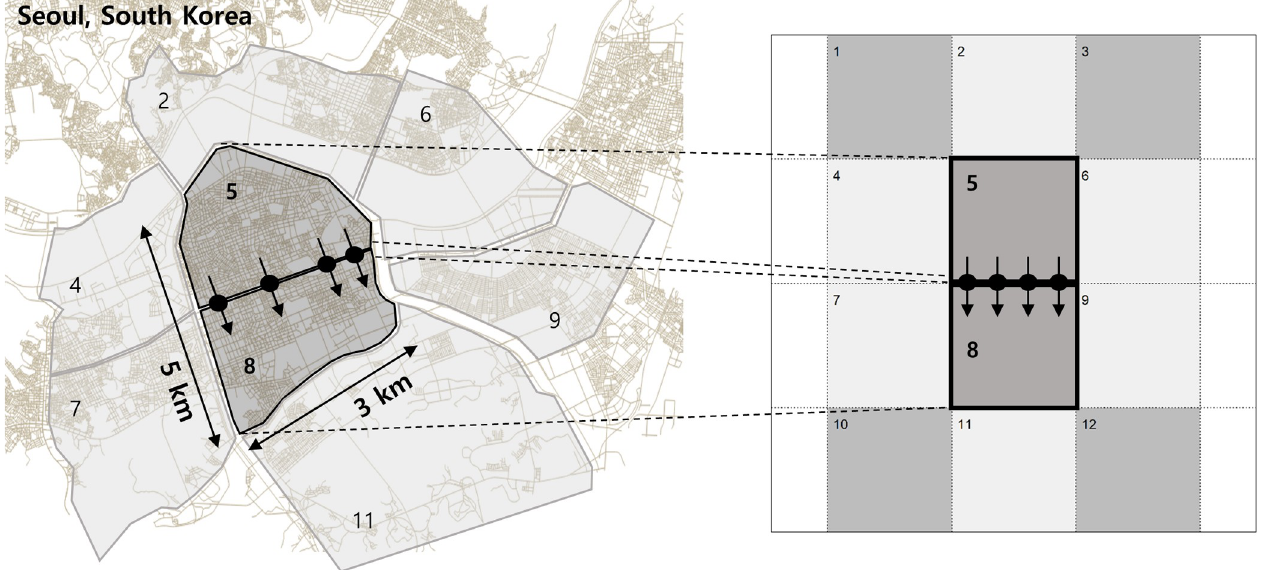
Fig 2. The target area (Gangnam district, Seoul, South Korea). (Drawn by authors using QGIS program, data source: public data portal of South Korea, the data are free source for everyone, the authors did not have any special privileges that others would have in obtaining the data, Data source: https://www.data. go.kr/data/15025526/fileData.do).